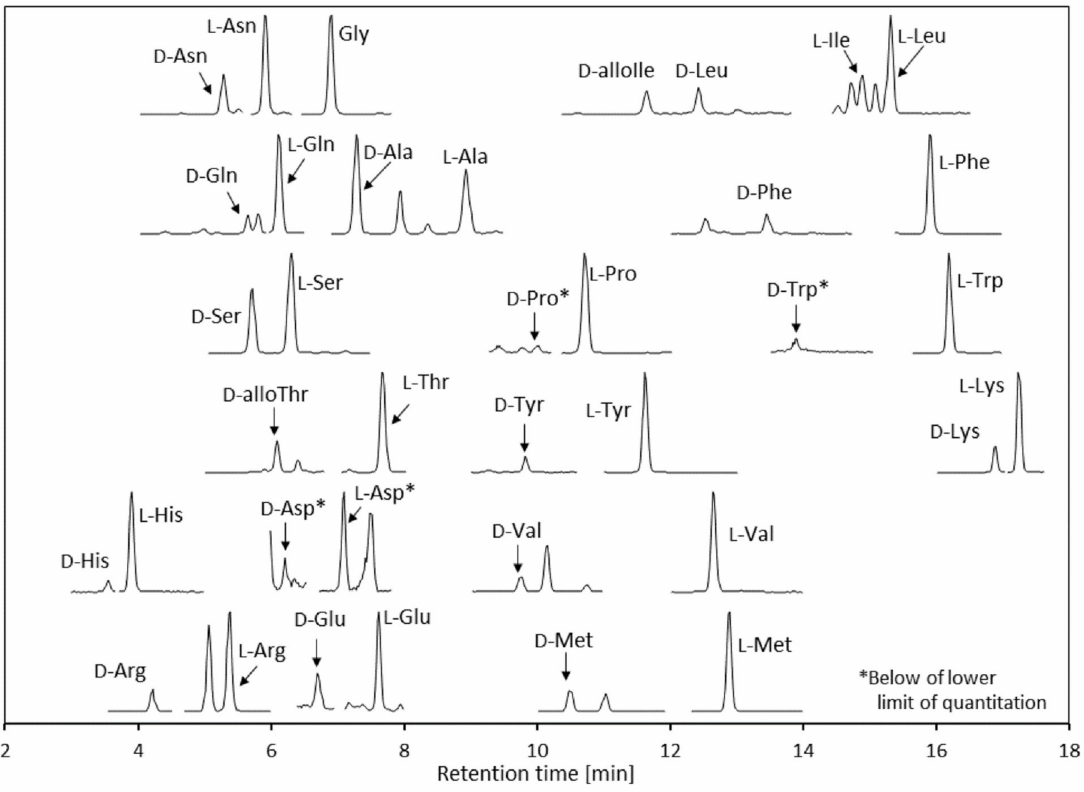
Figure 9. Chromatograms of D - and L -amino acids and glycine in human urine sample. Reproduced with permission from the authors of